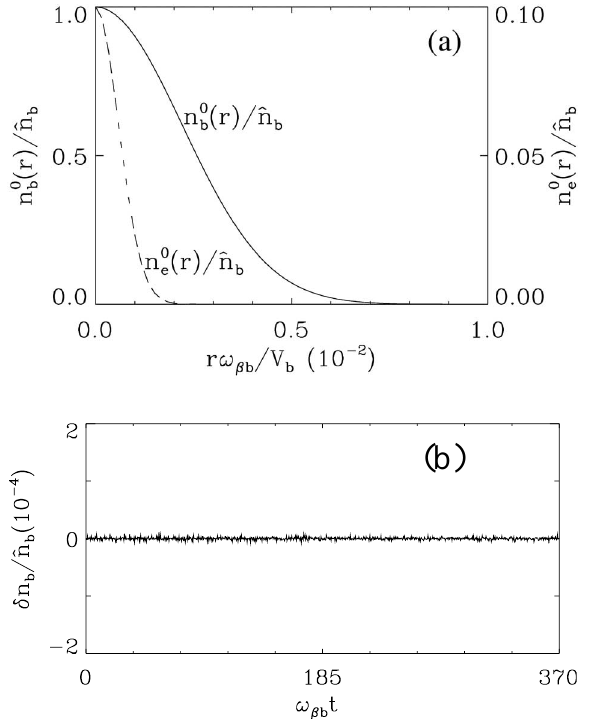
FIG. 6. Plots of (a) equilibrium proton and electron density profiles and (b) perturbation time history for warm electrons with T e (cid:1) (cid:3) T b (cid:1) (cid:1) 0.130